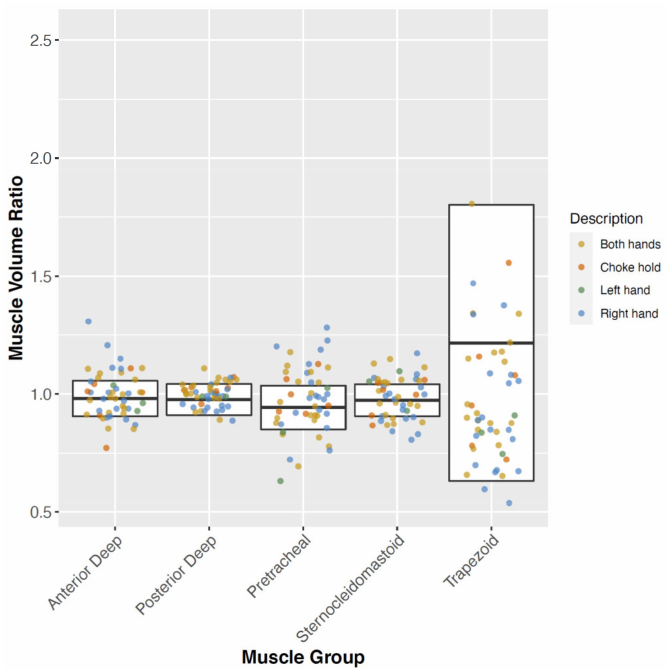
Figure 2. Modified boxplot (mean ± standard deviation instead of the median, 1st and 3rd quantiles) of all cases (control and strangulation), with the different muscle groups on the x -axis and the muscle volume ratio on the y -axis. The white box shows the physiological variability in asymmetry as defined by the control group (mean ± standard deviation), and the scattered colored points indicate the muscle volume ratios from all strangulation cases (yellow, both hands; orange, choke hold; green, left hand; and blue, right